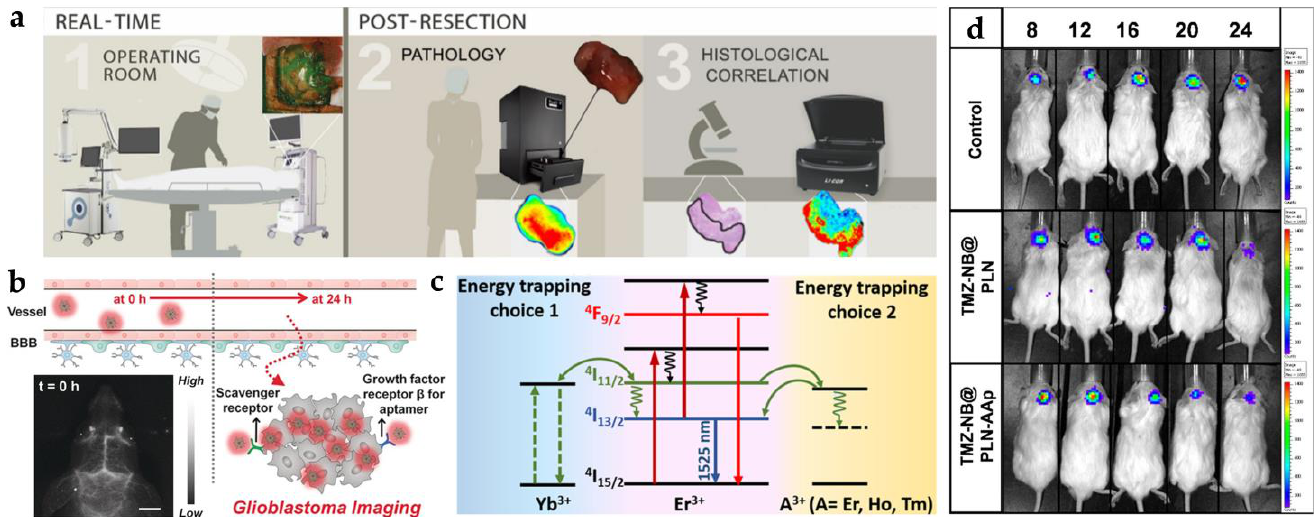
Figure 4. The common nanoprobes in glioblastoma imaging. ( a ) Three kinds of workflow in glioblastoma imaging with cetuximab-IRDye800D [48]. ( b ) Illustration of blood – brain barrier crossing with targeted NIR-II fluorescence in brain vessel imaging [64]. ( c ) Mechanism of energy transfer with Yb 3+ , Er 3+ , and A 3+ downconversion system [69]. ( d ) The IVIS image from persistent luminescent ZnGa 2 O 4 :Cr 3+ , Sn 4+ with the tumor change (days 8, 12, 16, 20, and 24) [75]. Adapted from [48], [64], [69], and [75], Springer 2018, Wiley 2020, Elsevier 2020, and American Chemical Society 2021.